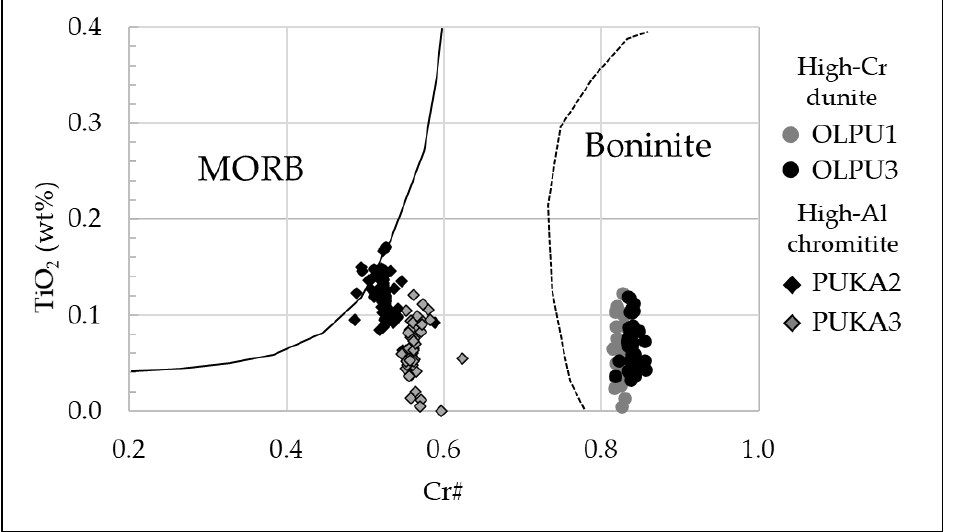
Figure 13. The TiO 2 content of spinel vs. its Cr# value in Iballe high-Cr dunites and high-Al chromitites; compositional fields of MORB and boninite are from Dick and Bullen [50].